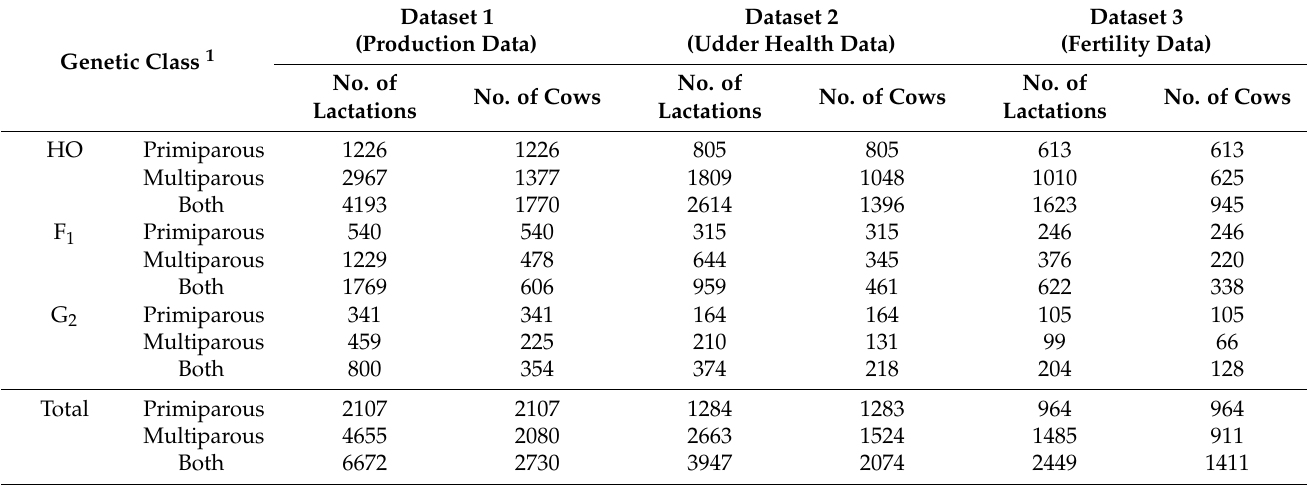
Table 3. Description of the three datasets used for the statistical analyses of milk production (dataset 1), udder health performance (dataset 2) and reproduction performance (dataset 3). For each, the number of lactations and the number of cows for Holstein (HO) purebred, first and second generation of crosses (F 1 and G 2 , respectively) obtained from three-breed rotational crossbreeding into purebred HO herds are